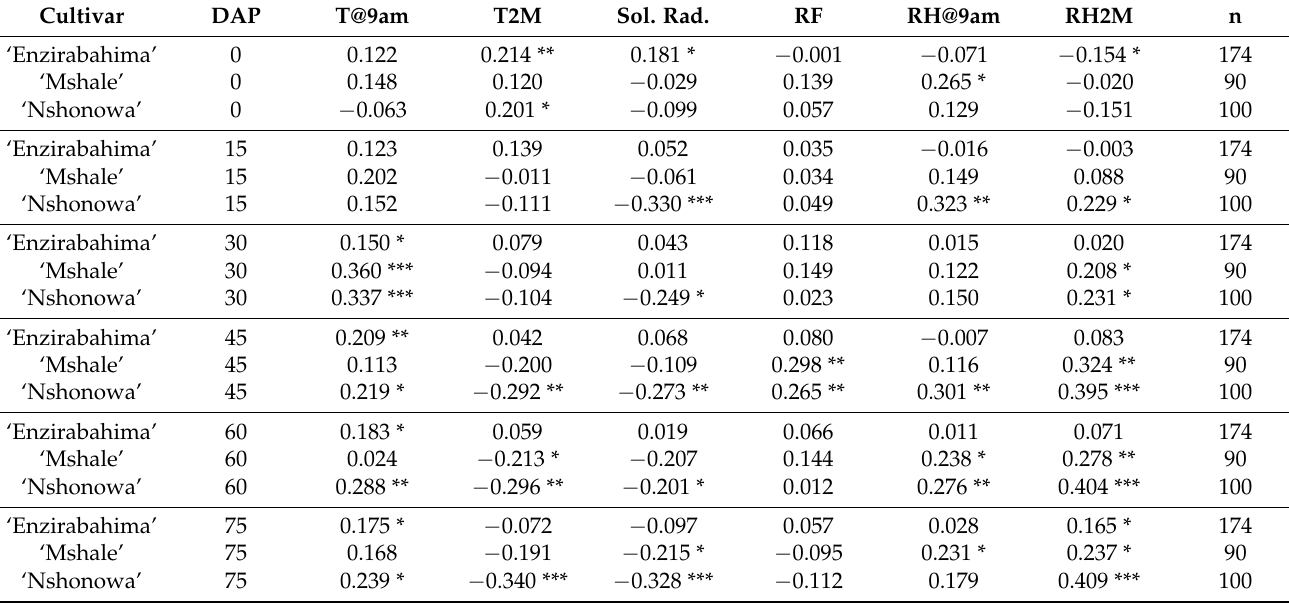
Table 4. Correlation coefficients of weather attributes with seed set in East African Highland Cooking bananas between the time of pollination (zero days) and 75 days after